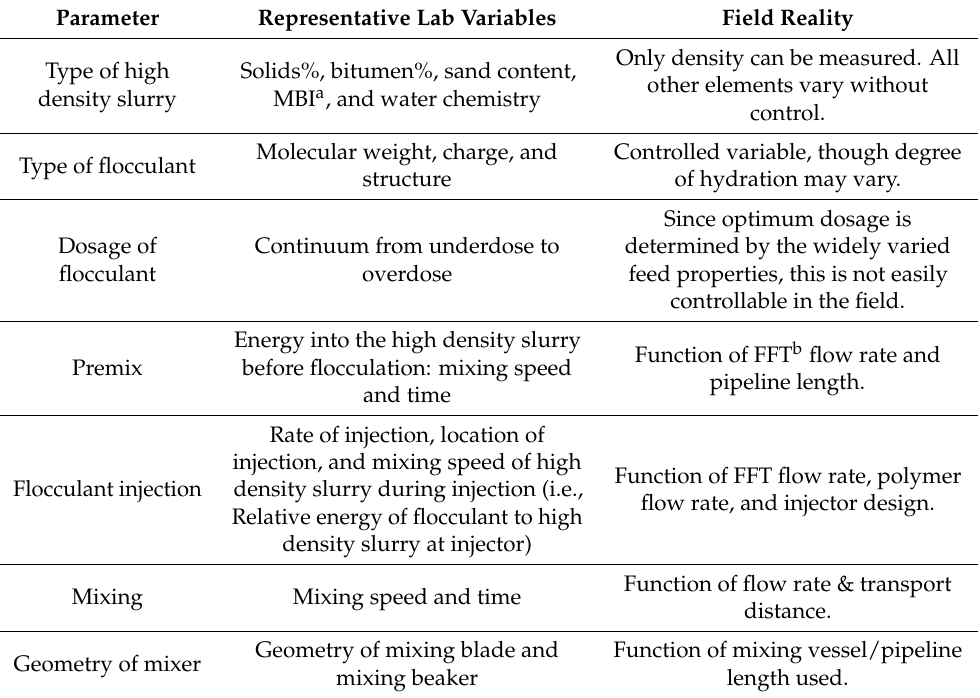
Table 1. Key parameters affecting the high density slurry dewatering performance. Parameter Representative Lab